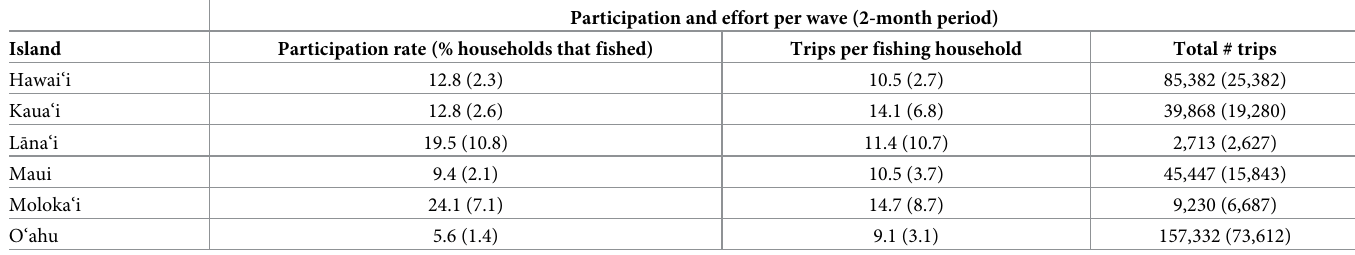
Table 1. Recreational fishing effort. Data come from MRIP telephone surveys in 2004–2013. Data are summarized as mean and standard deviation of values per wave (i.e., for the 60 2-month periods in that 10-year period). Participation rate is proportion of households in which someone fished in the preceding wave; trips per household represents the number of fishing trips per fishing household in that period. Total # trips was calculated using Eq 1. Number of households ranged from 63,209 to 64,909 for Hawai‘i Island, 21,968 to 22,390 for Kaua‘i, 1,068 to 1,074 for Lāna‘i, 43,505 to 49,080 for Maui, 2,525 to 2,561 for Moloka‘i, and 303,794 to 309,803 for